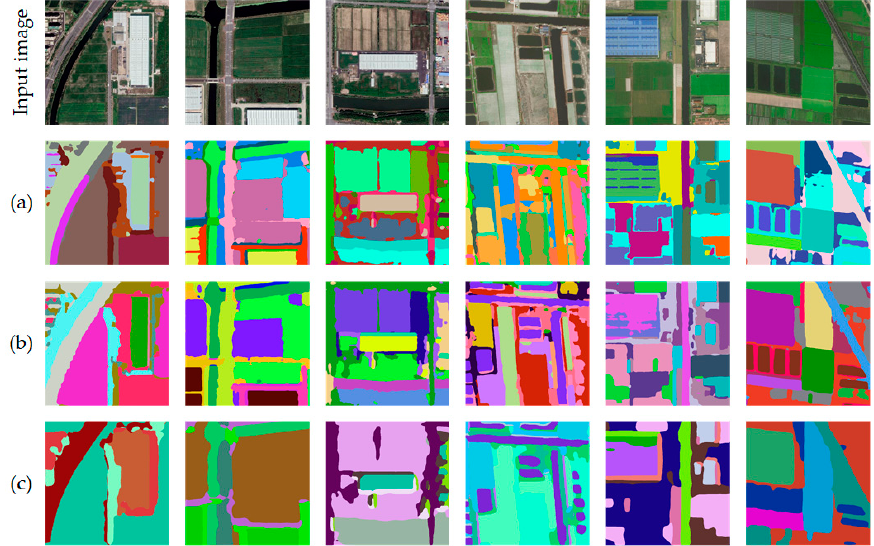
Figure 10. Representative examples of image segmentation results driven by diverse designs of our three deep learning models: ( a ) none down- and up-sampling operation, ( b ) one down- and up-sampling operation, ( c ) two down- and up-sampling operations. The left three images are from Shanghai dataset, while the right ones are from Zhejiang dataset.